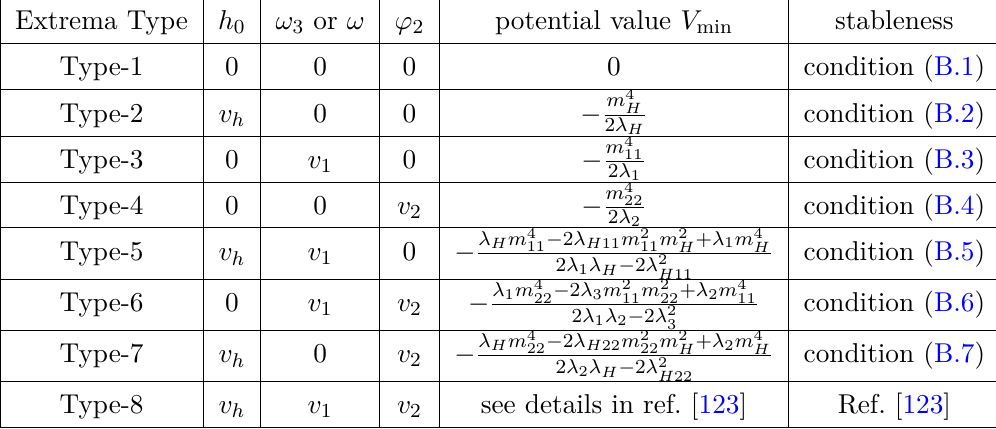
Figure 8. The evolution of the vacuum ( φ ≡ T , and their corresponding potential values (right) are shown for BM1 (upper panels) and BM2 (lower panels). Here the critical and nucleation temperatures are denoted by the dashed vertical lines,